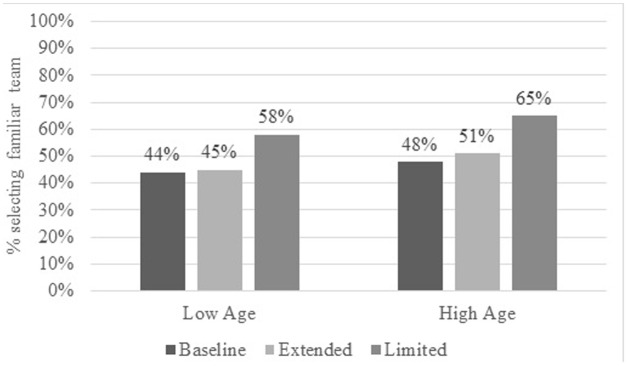
Participants’ preferences for the familiar team by age and (experimental) influences on occupational future time perspective (contextual scenarios: baseline, extended, and limited). The two age groups (low and high) were divided by median split at 47 years (nold = 231, Mold = 54.86; SDold = 4.88; nyoung = 205, Myoung = 35.95, SDyoung = 7.77).